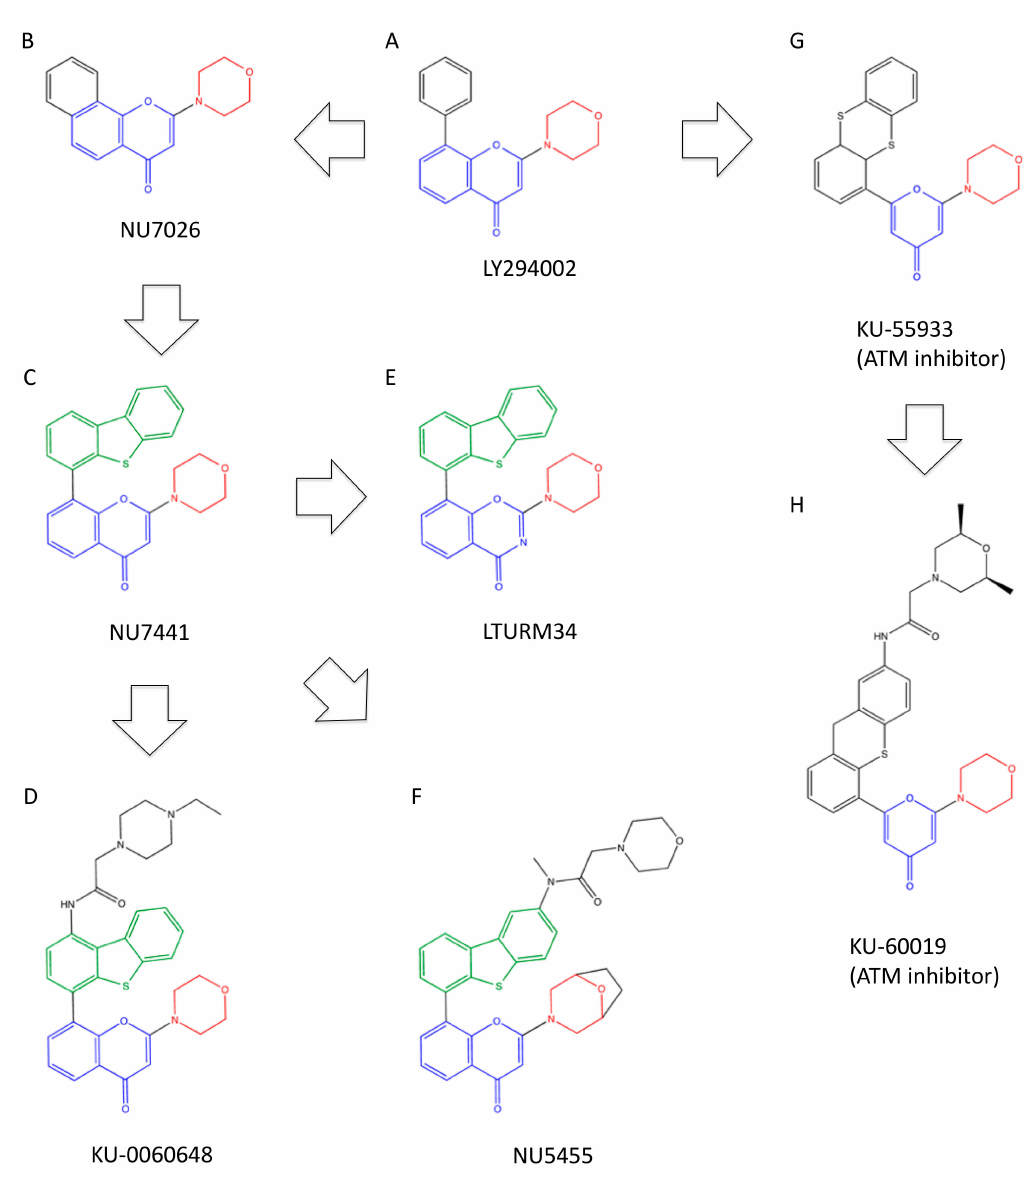
Figure 5. Structures and mutual relationships of LY294002-derived inhibitors. ( A ) LY294002, ( B ) NU7026, ( C ) NU7441, ( D ) KU-0060648, ( E ) LTURM34, ( F ) NU5455, ( G ) KU55933, ( H ) KU-60019. Red: morpholine structures, blue: chromen-4-one or pyran-4-one structures, green: dibenzothiophen